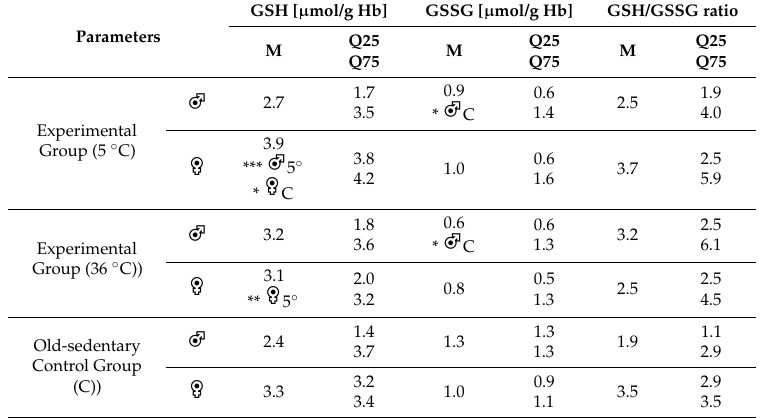
Table 2. Erythrocyte and plasma TBARS and 8-isoprostane concentrations in experimental groups (5 °C and 36 °C), control group and sex-specific differences.